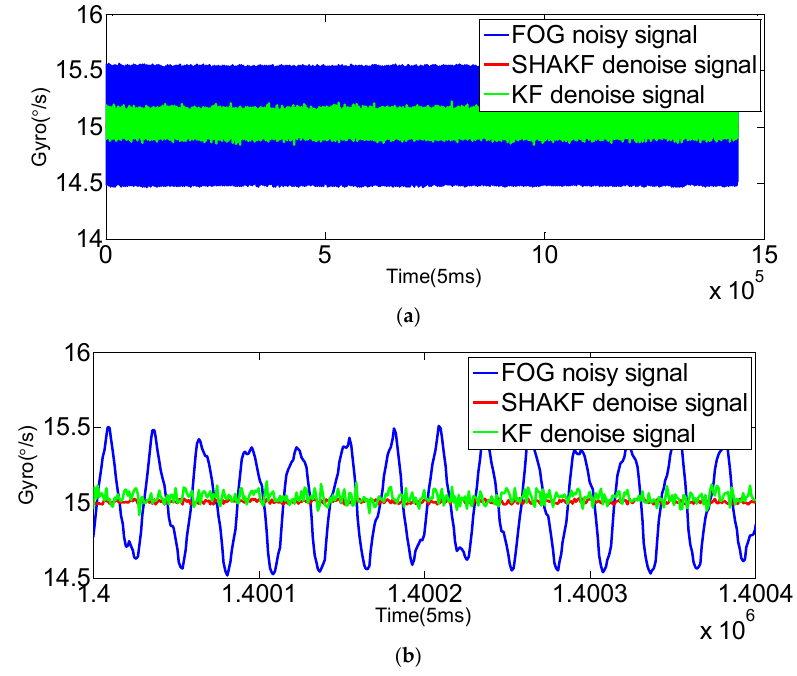
Figure 11. Comparison of the results before and after denoising for the FOG dynamic signal at a rate of 15°/s. ( a ) Denoising the results of the FOG dynamic signal ( x -axis) for 2 h; ( b ) local enlarged graphs.